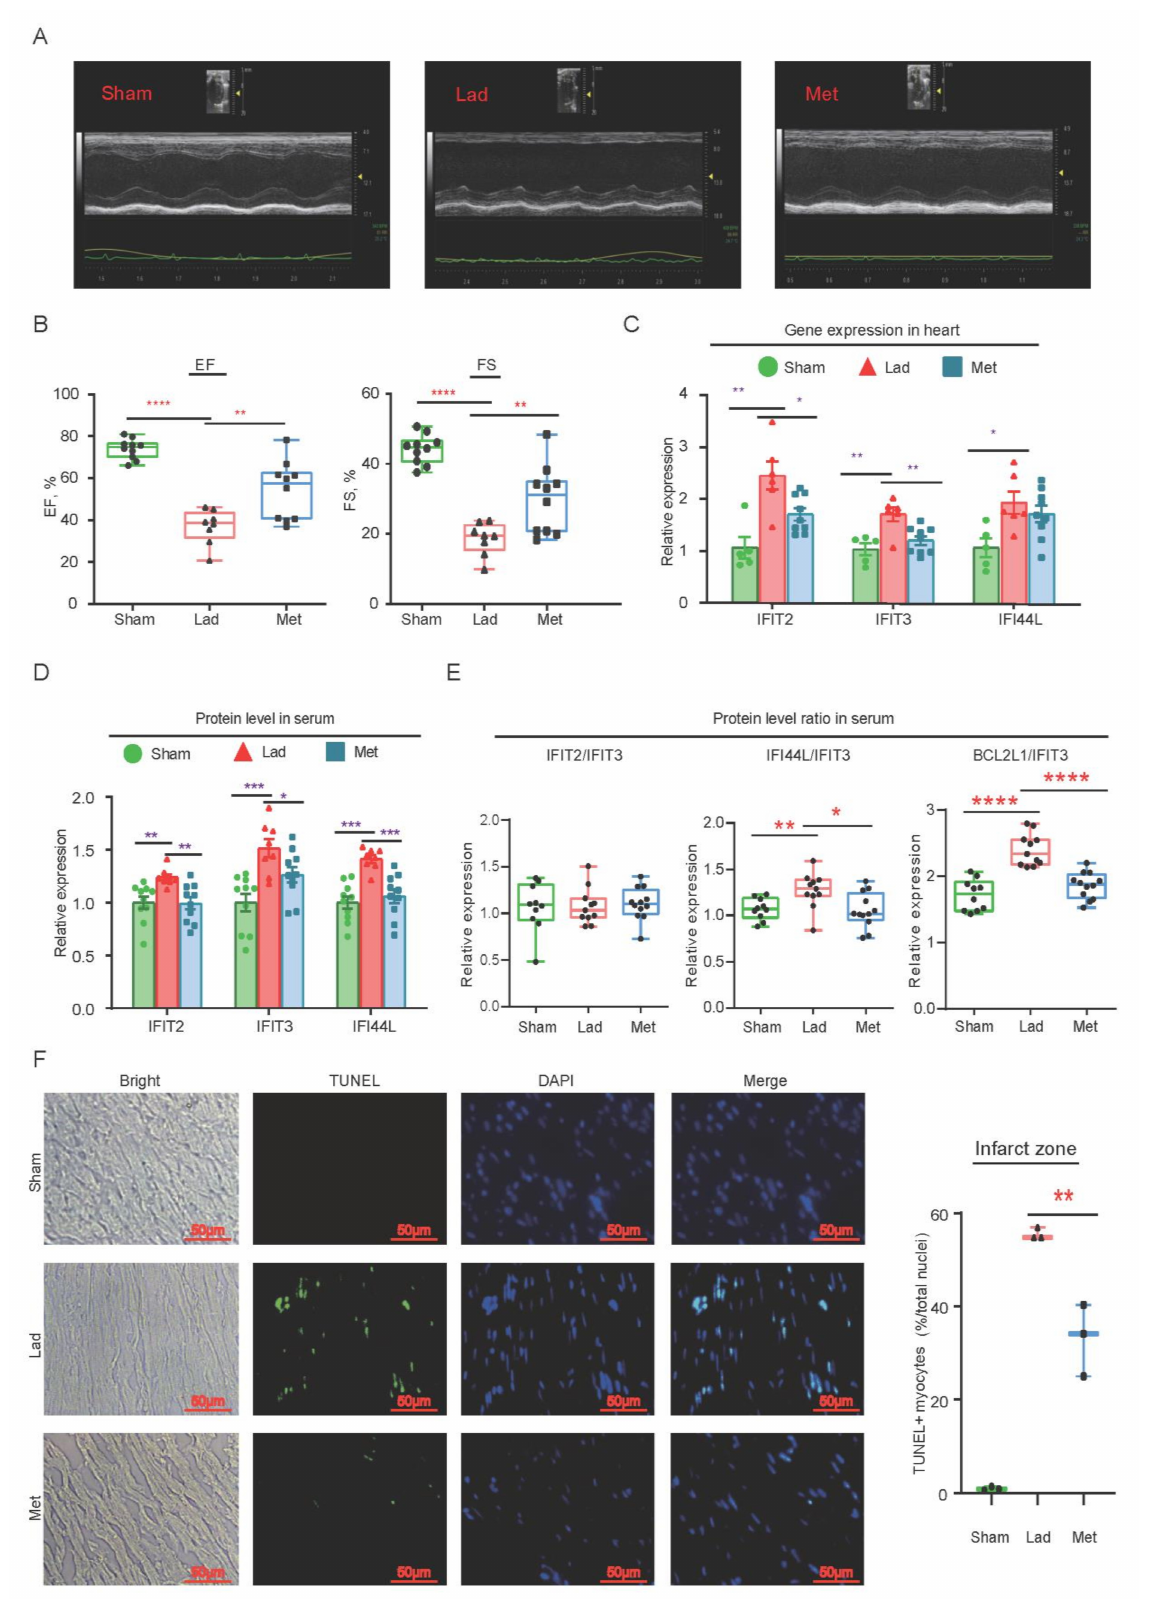
Figure 5. Cardiac function evaluation in rats after continuous administration Metoprolol. ( A ) The echocardiographic analysis of different groups, including Sham, myocardial infarction (Lad) and Met group. ( B ) The average of EF and FS in the Met group were significantly higher than Lad group. Sham group: n = 10; Lad group n = 8; Met group: n = 10. ( C )